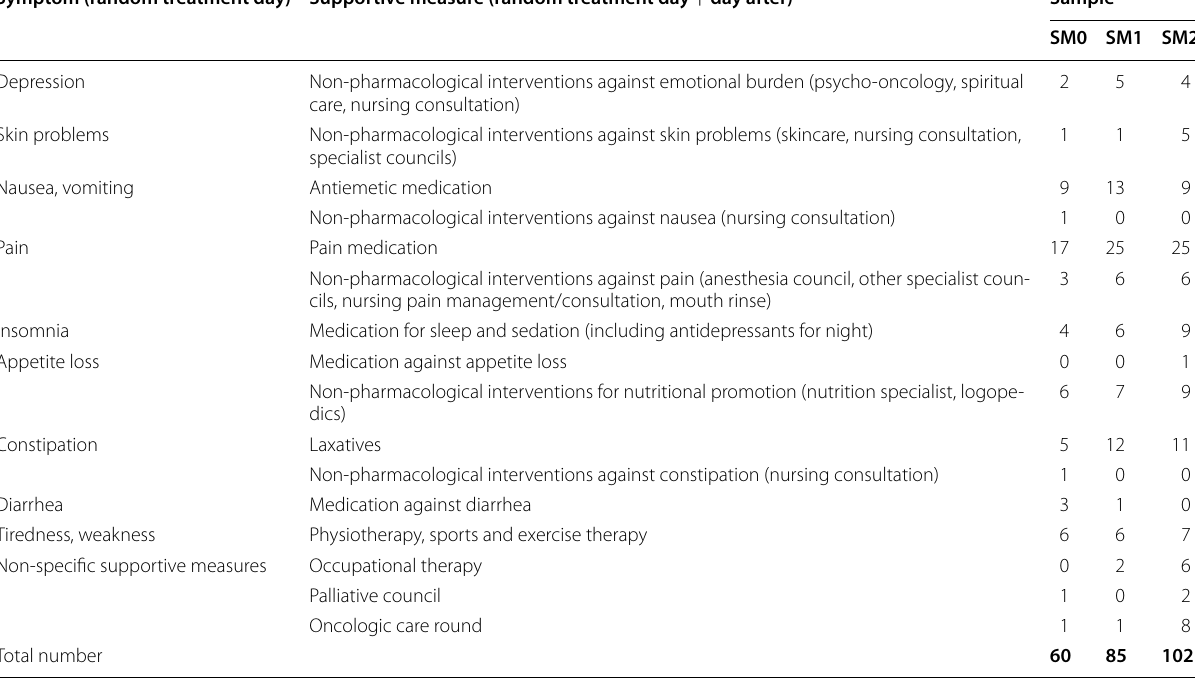
Table 4 Comparison of samples without/with symptom monitoring regarding the number of initiated supportive measures (n sample)